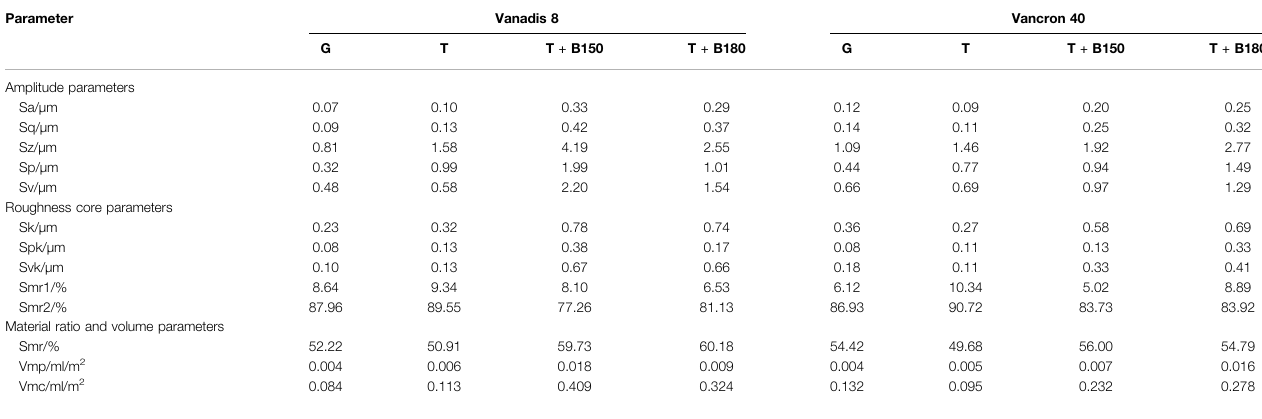
TABLE 3 | Mean values of roughness parameters for Vanadis 8 and Vancron 40 steel samples after selected mechanical processes. Parameter Vanadis 8 Vancron 40 G Amplitude parameters Sa/ μ